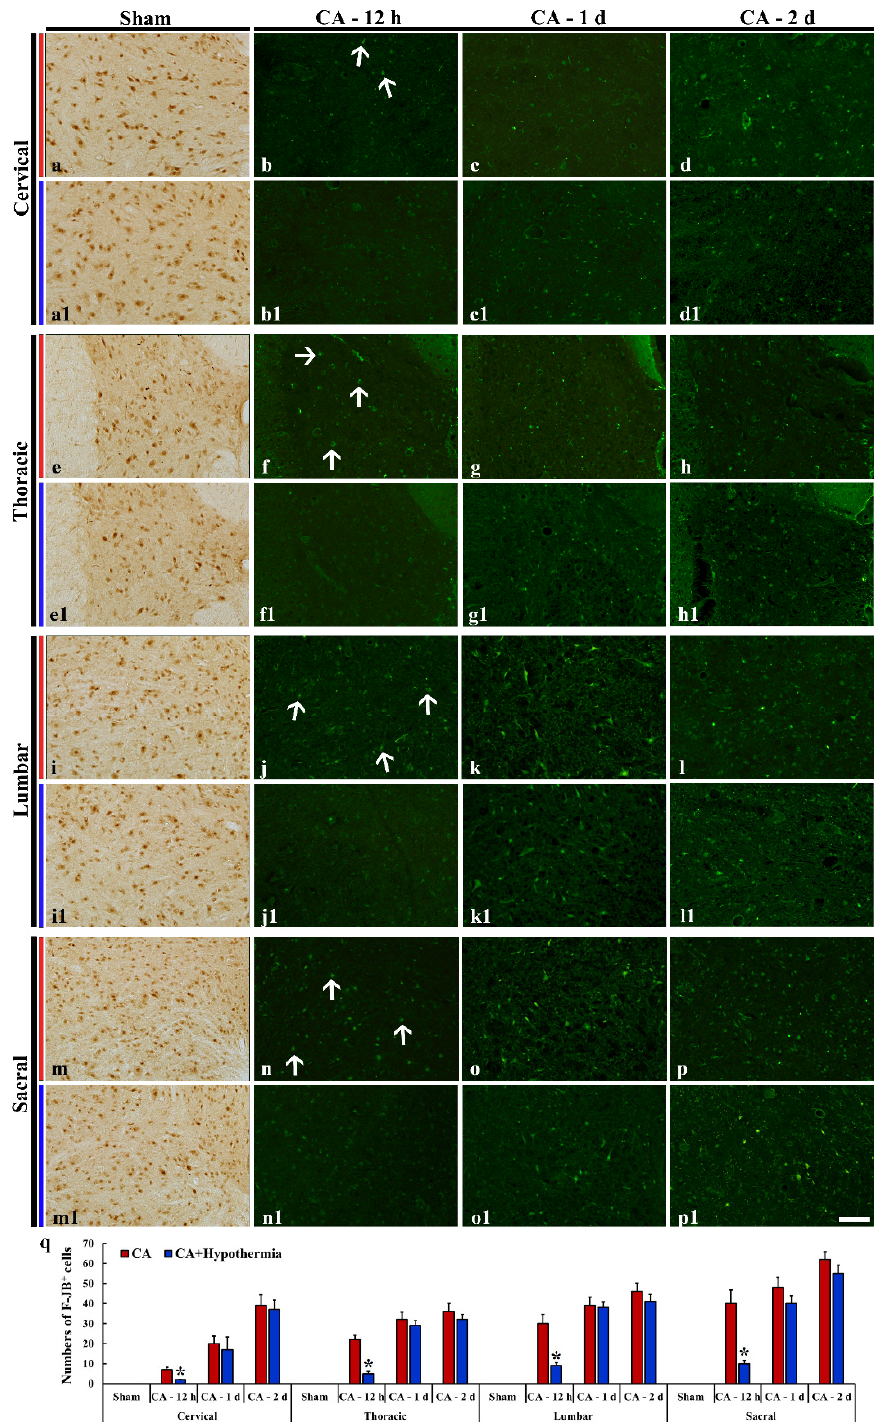
Figure 4. NeuN immunohistochemical staining in the intermediate zone of the spinal cord of the sham operated ( a , a1 , e , e1 , i , i1 , m , m1 ) and F-J B histofluorescence staining in the intermediate zone of the spinal cord of the CA operated ( b – d , f – h , j – l , n – p ), and CA/hypothermia operated ( b1 – d1 , f1 – h1 , j1 – l1 , n1 – p1 ) groups. Detection of F-JB positive cells (arrows) starts from 12 h post-CA, showing that numbers of F-JB positive cells are different between spinal cord levels. Note that hypothermia significantly reduces numbers of F-JB positive cells in all the levels only at 12 h after CA. Scale bars = 100 µ m. ( q ) mean numbers of F-JB positive cells in the CA and CA/hypothermia groups ( n = 9 per group, * p < 0.05, vs. each CA group). The bars indicate the means ±